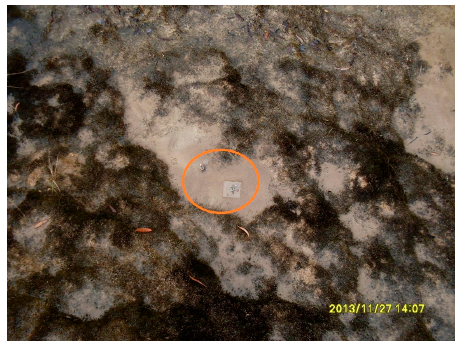
Figure 3. Photograph at one of the studied sites.